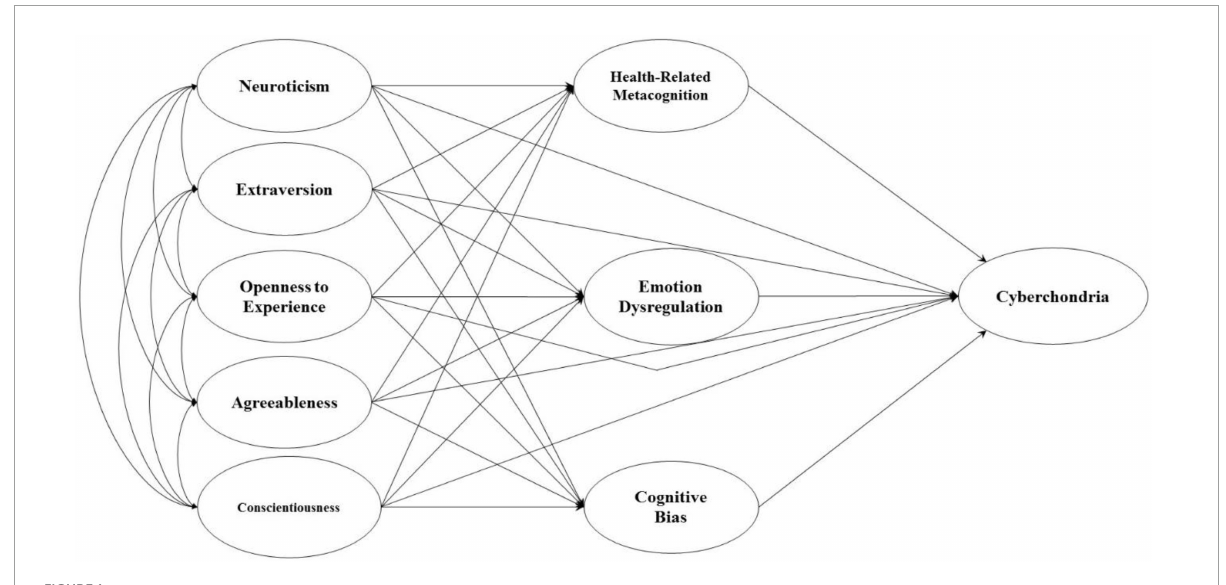
FIGURE1 Conceptual model of